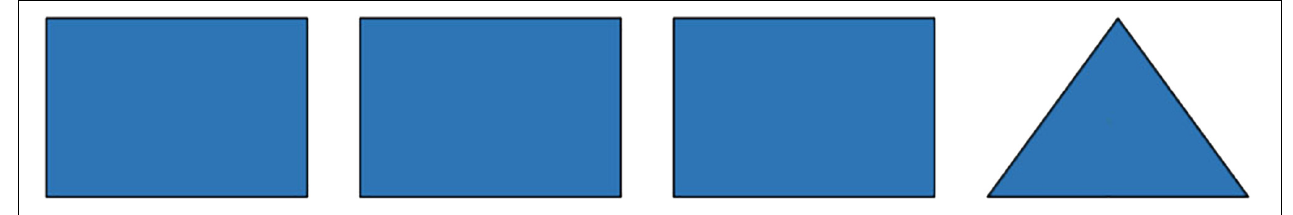
FIGURE 1 | Example of one item of the Odd One Out Cognitive Task (Hauser et al., 2021: 18). (CC-BY 4.0).